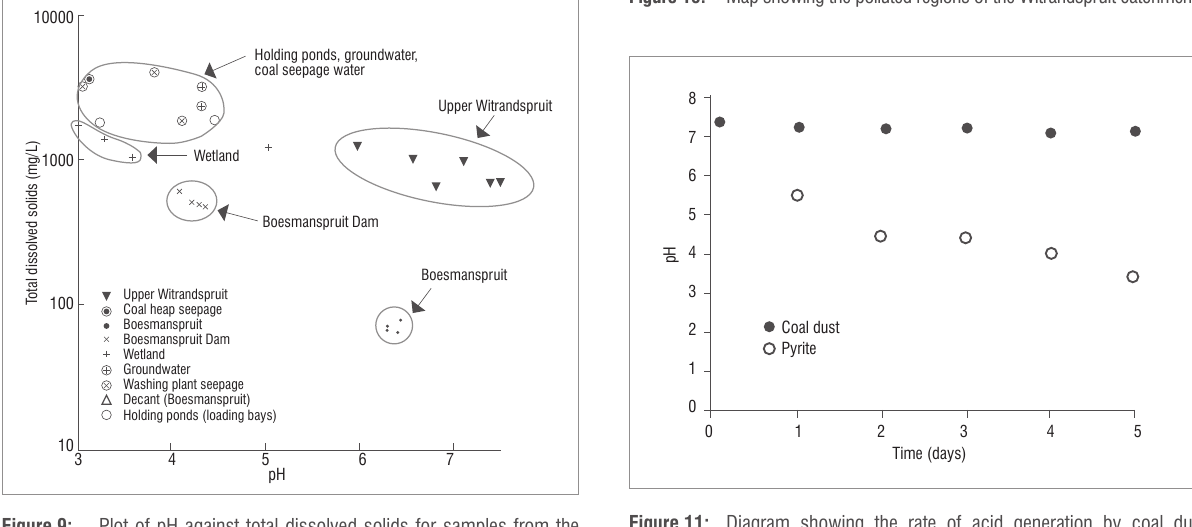
Figure 10: Map showing the polluted regions of the Witrandspruit catchment.